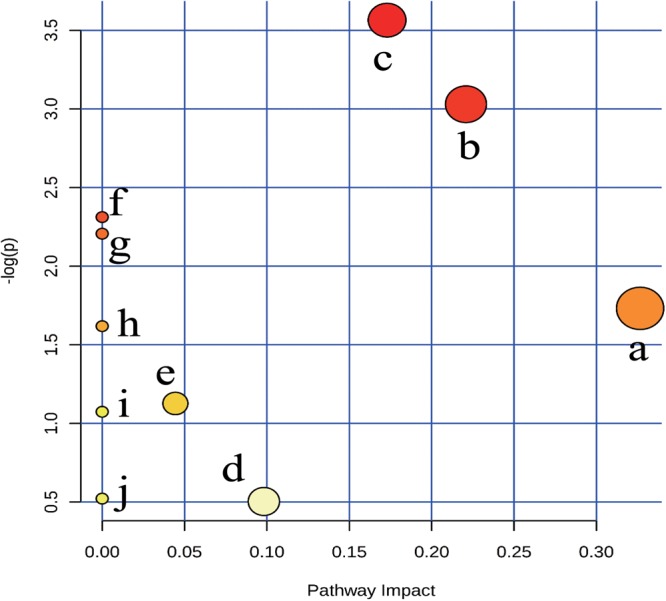
Summary of pathway analysis of plasma samples collected from anaemia rats. (a) pantothenate and CoA biosynthesis, (b) cysteine and methionine metabolism, (c) sphingolipid metabolism, (d) steroid hormone biosynthesis, (e) glycerophospholipid metabolism, (f) biosynthesis of unsaturated fatty acids, (g) nitrogen metabolism, (h) retinol metabolism, (i) glycine, serine and threonine metabolism;, (j) purine metabolism.